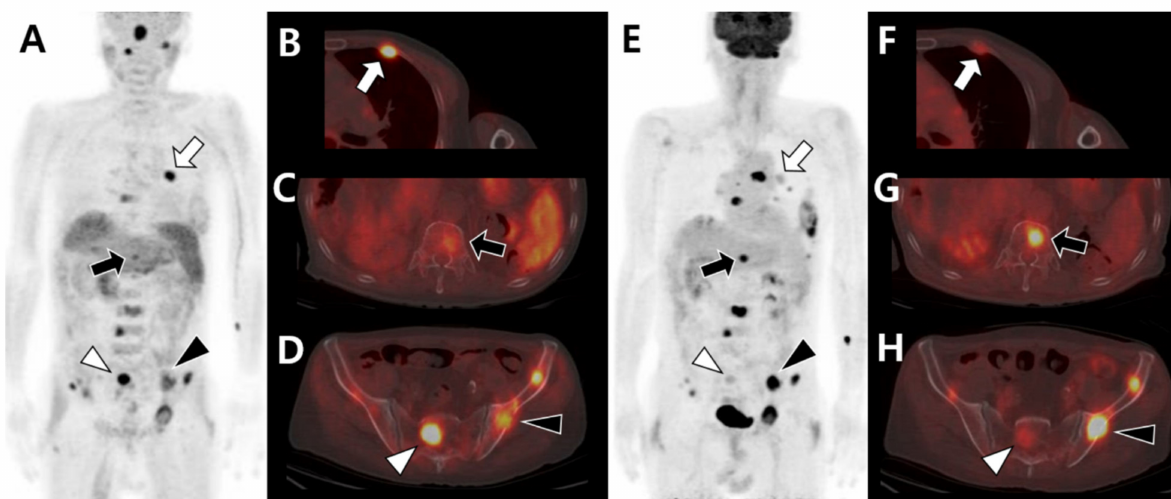
Figure 5. Different tracer avidities according to involved sites of bone metastases in the same patient with hepatocellular carcinoma before therapy. 11 C-acetate positron emission tomography (PET)/computed tomography (CT) ( A – D ) shows intense acetate uptake in metastatic lesions of the left third rib (white arrow in A , B ) and sacrum (white arrowhead in A , D ) but mild acetate uptake in the T12 vertebra (black arrow in A , C ) and left iliac bone (black arrowhead in A , D ). 18 F-fluorodeoxyglucose ( 18 F-FDG) PET/CT ( E – H ) shows mild FDG uptake in the left third rib (white arrow in E , F ) and sacrum (white arrowhead in E , H ) but intense FDG uptake in the T12 vertebra (black arrow in E , G ) and left iliac bone (black arrowhead in E , H